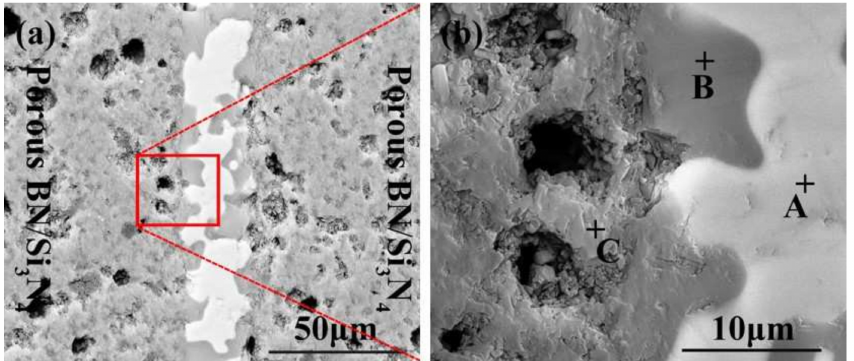
Figure 2. SEM micrographs of the reference welded joint brazed with SiCo38 alloy at 1320 ◦ C for 10 min ( a ), and ( b ) is a magnified surface marked in ( a